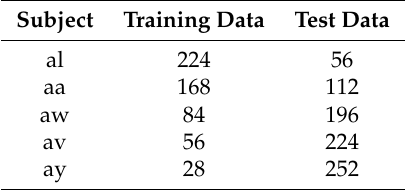
Table 1. BCI Competition III Dataset